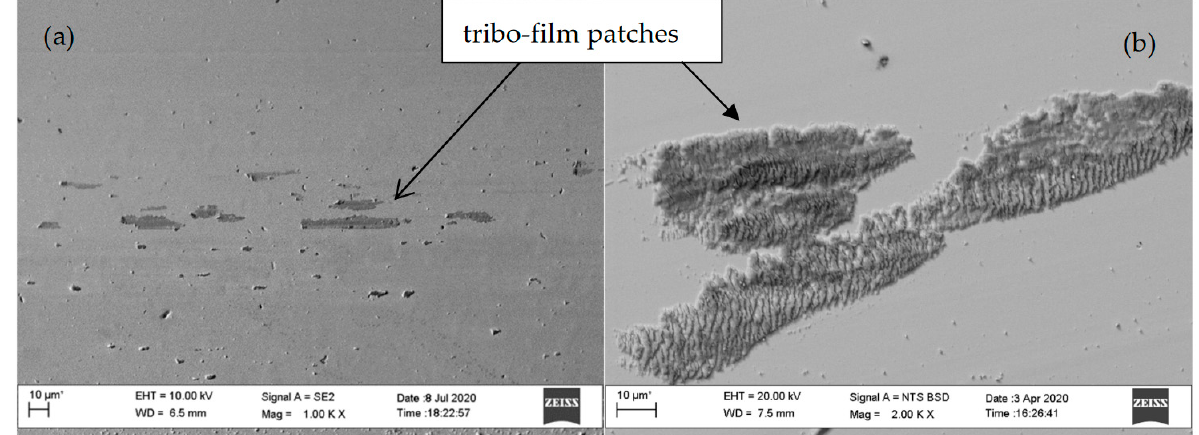
Figure 8. Wear tracks with the tribo-film patches ( a ) in the non-hydrogenated (0C 2 H 2 -0H 2 ) W-C coatings after test to 2000 m (reprinted with permission from Ref. [25], 2021, Elsevier) and ( b ) in the slightly hydrogenated (0C 2 H 2 –15H 2 ) W-C:H coating after test to 1100 m.